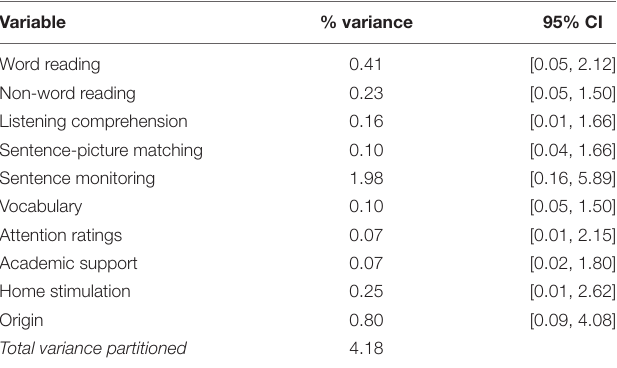
TABLE 5 | Relative importance metrics in the dominance analysis of regressors, controlling age, non-verbal reasoning, and